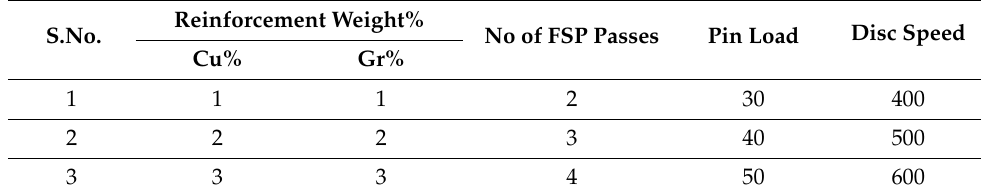
Table 1. Pin-on disc wear test input factors and levels.